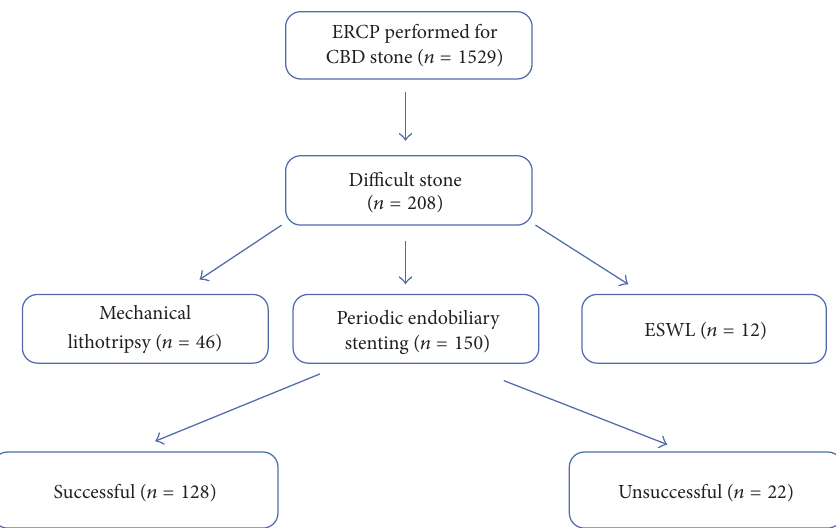
Figure 1: Design of the study population (ESWL: extracorporeal shock wave